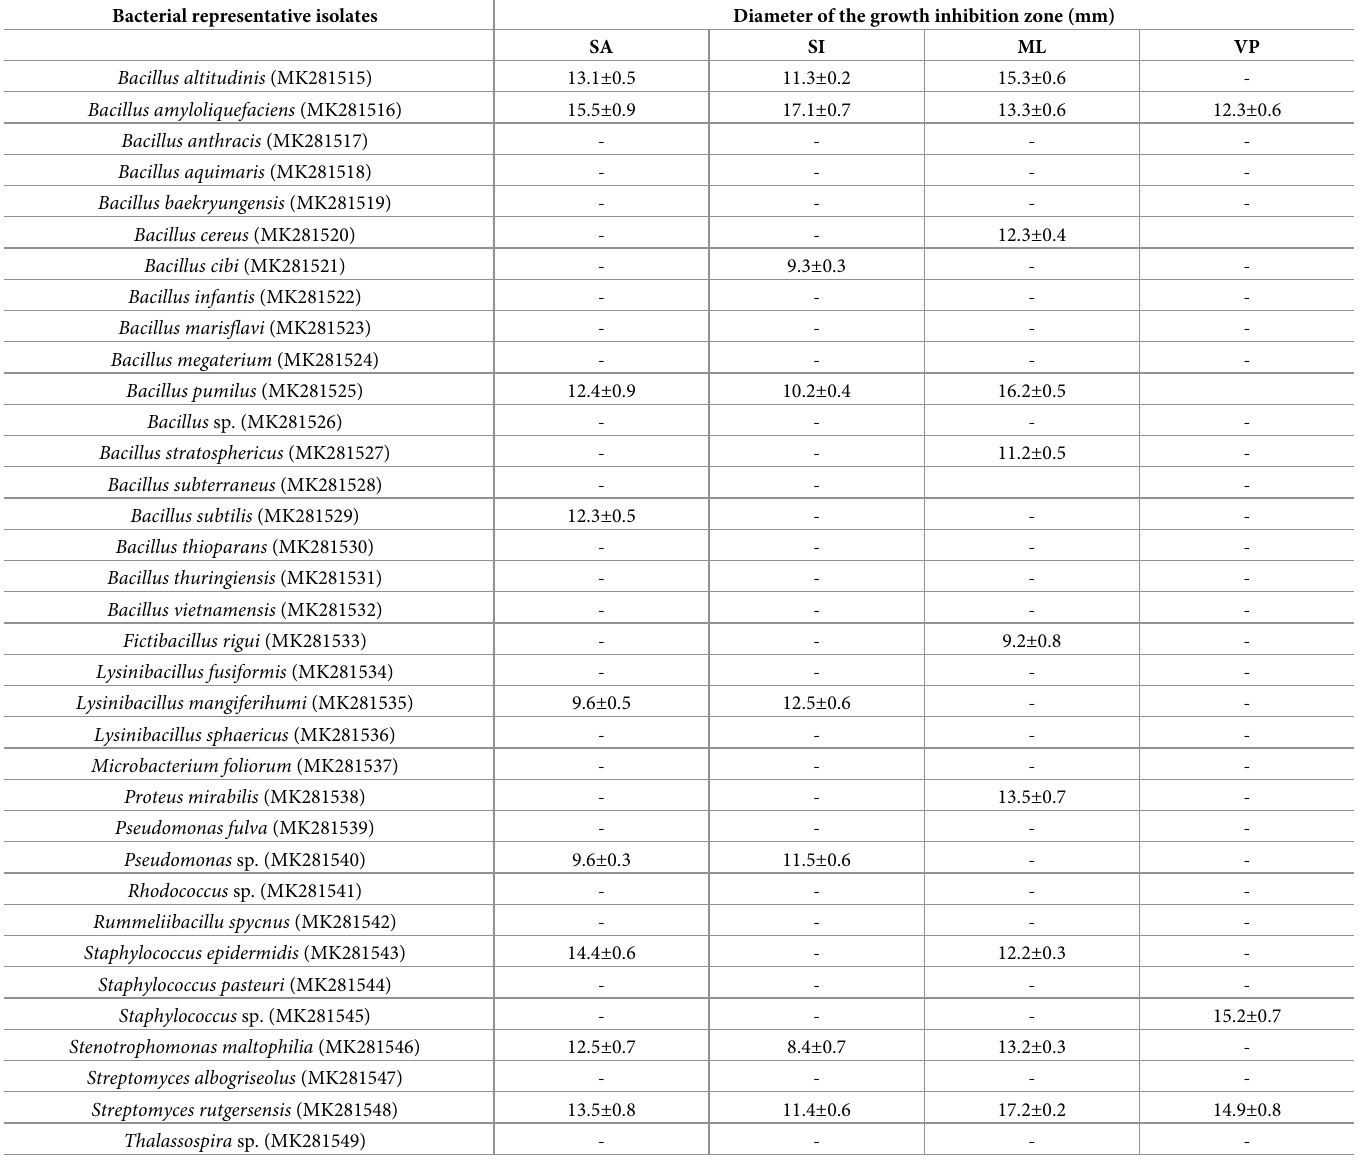
Table 5. Antibacterial activity of aerobic culturable bacteria isolated from tilapia gut. Bacterial representative